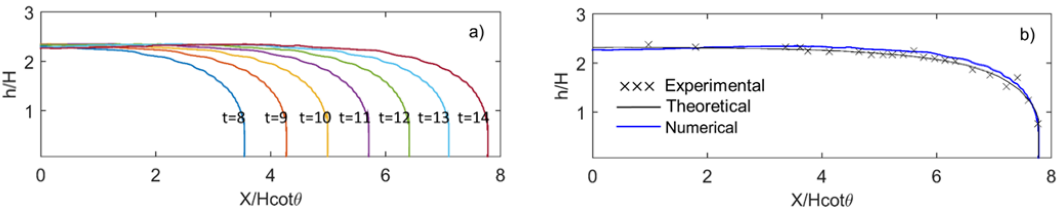
Figure 4. The free-surface profiles of Bingham flow on an inclined plane. ( a ) Snapshots (unit: s); ( b ) validation at t = 14 s. The experimental data and theoretical results are obtained from Liu [12]. The numerical results are simulated by the Bingham model.